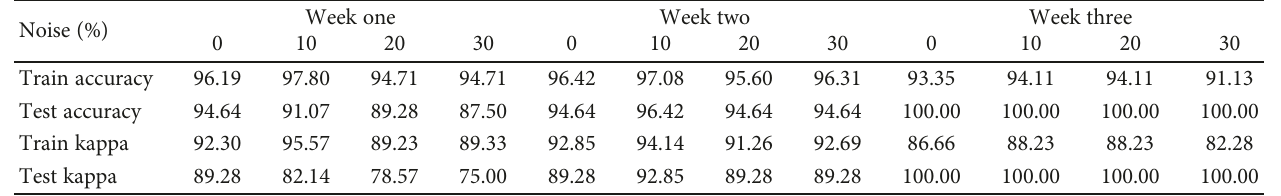
Table 3: oRF-SVM classi fi cation accuracies for three simulated noise levels for three weeks of infestation. Noise